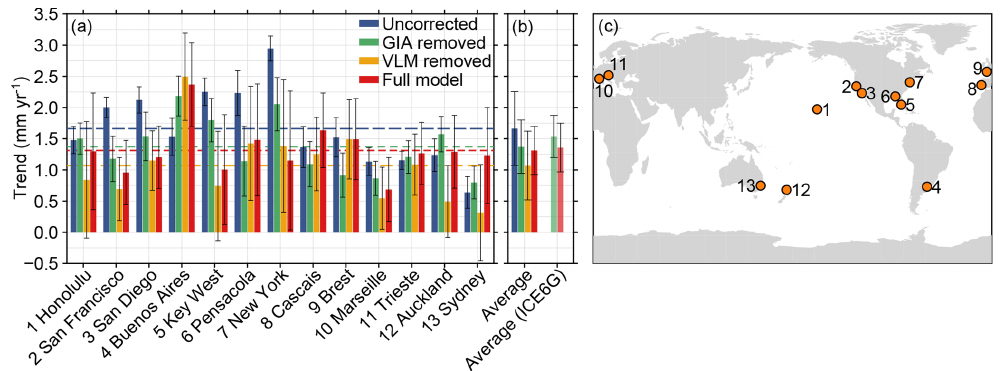
Figure 13. The effect of vertical land motion on 20th-century linear trends in tide-gauge records. (a) Linear trends in long tide-gauge records (1901–2000), with various correction models applied for vertical land motion. Blue: no correction, green: GIA RSL removed, yellow: observed VLM trend removed, and red: GIA and residual VLM trend removed. The dashed lines show the median trends for each correction, which are also depicted in panel (b) . The error bars in panel (b) denote the inter-station standard deviations of the trends for each model. Panel (c) shows the locations of the tide gauges. The black bars denote the 1 σ